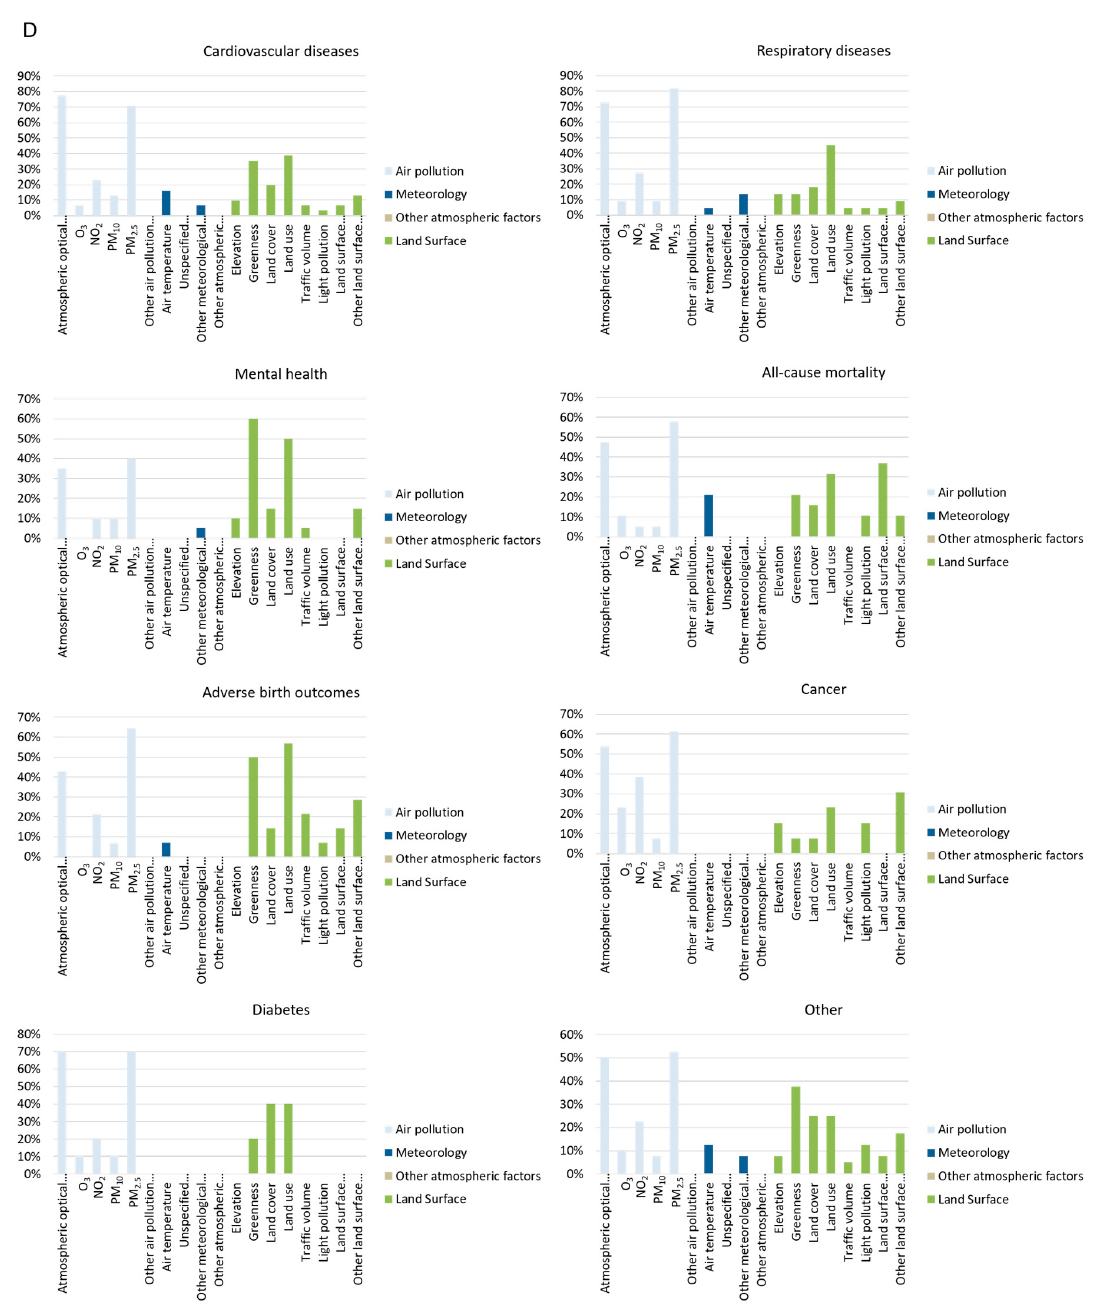
Figure 10. ( A ) Investigated disease versus Earth Observation parameters on a broader and finer ( B ) scale with a detailed view into atmospheric parameters ( C ); ( D ) Detailed view of most popularly observed parameters in reviewed articles coinciding with investigated disease groups.